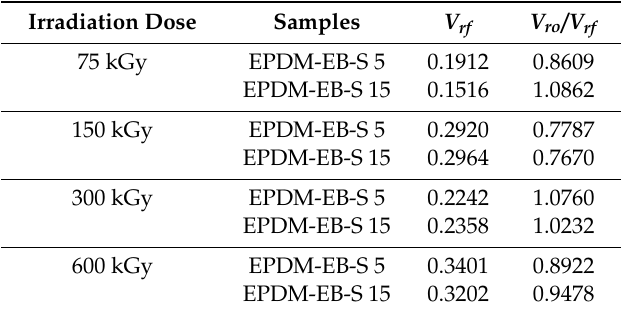
Table 2. V rf and V ro / V rf of EPDM-S composites determined in toluene. Irradiation Dose Samples